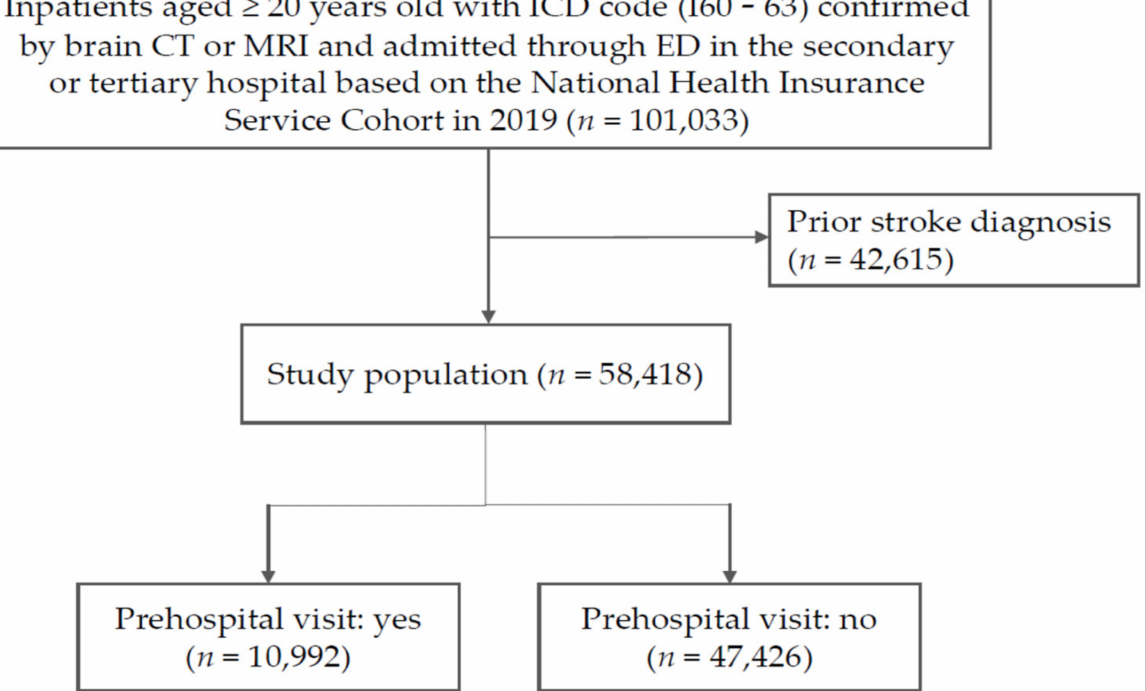
Figure 1. Study population. ICD, International Classification of Diseases; CT, computed tomography; MRI, magnetic resonance imaging; ED, emergency